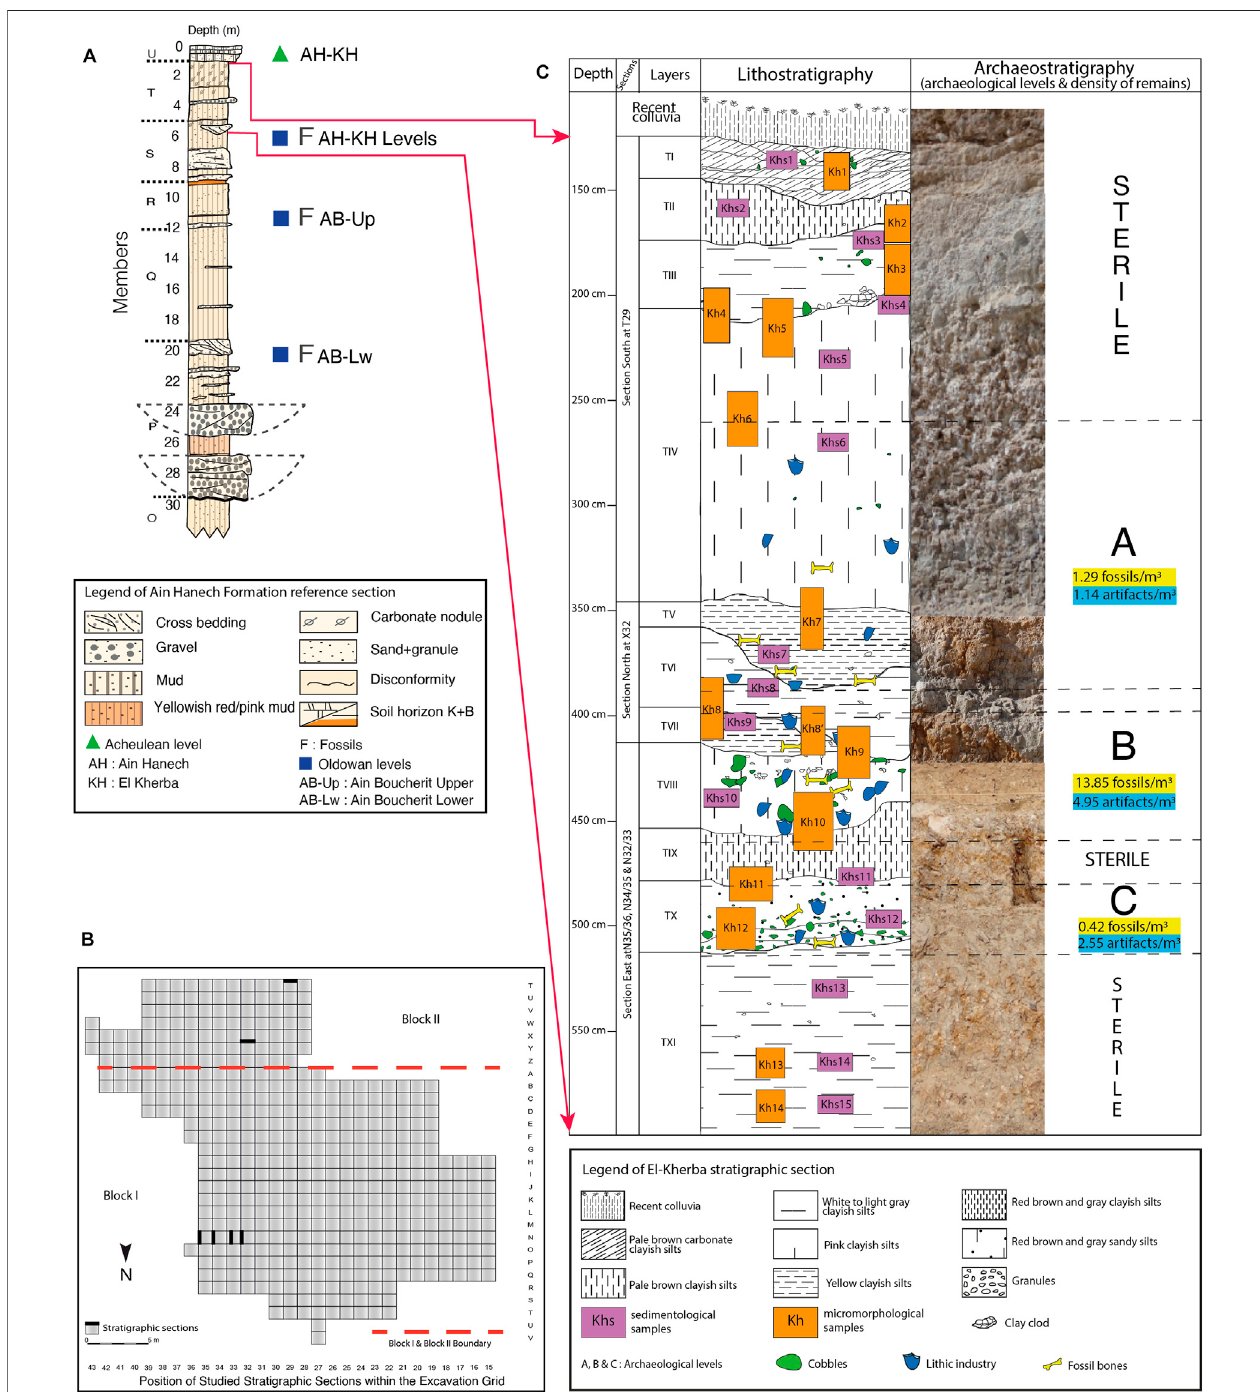
FIGURE 3 | El Kherba site stratigraphy including (A) position of El Kherba deposits within the Ain Hanech formation, (B) position of studied stratigraphic sections within the excavation grid, and (C) detailed stratigraphic pro fi le and location of sampling for sediment and micromorphological studies.